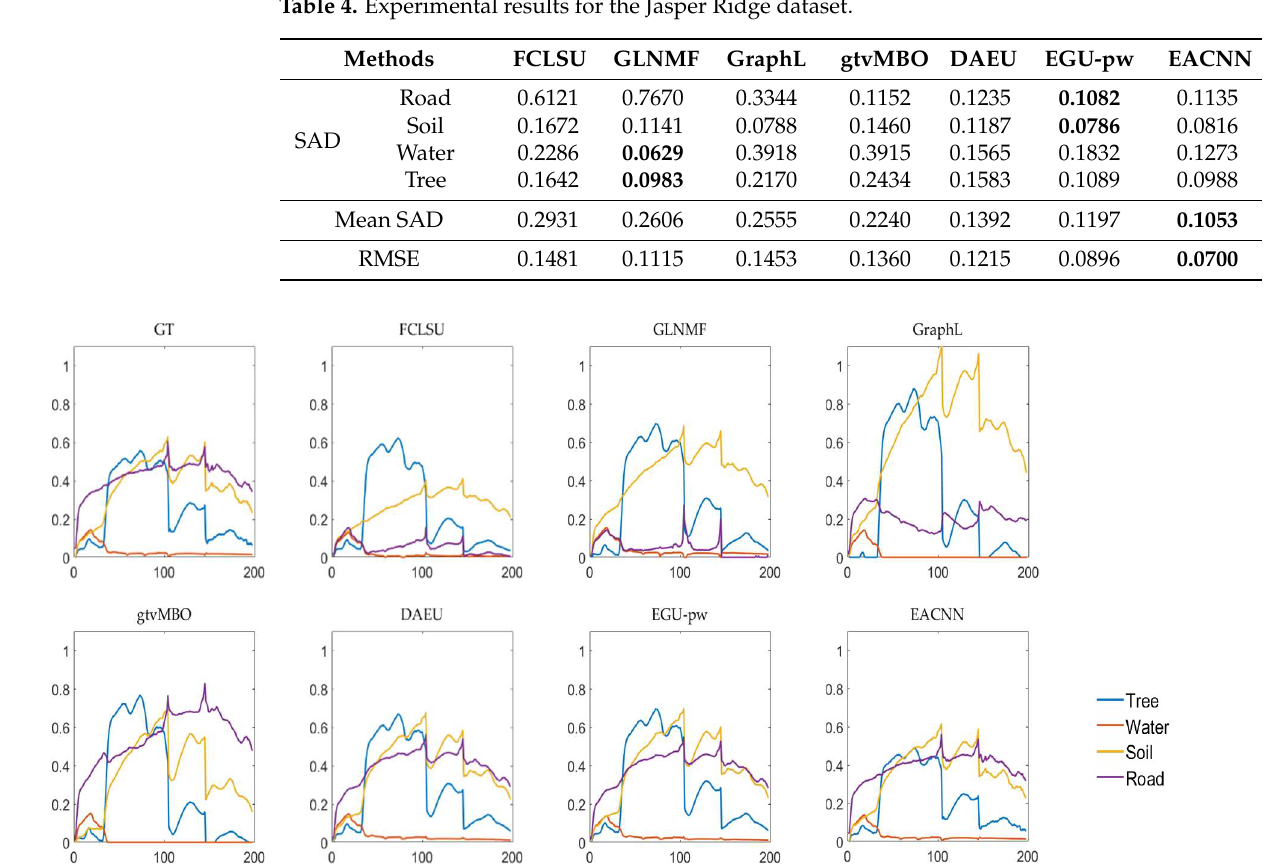
Figure 6. The endmember extraction results of the Jasper Ridge dataset. Table 4. Experimental results for the Jasper Ridge dataset.